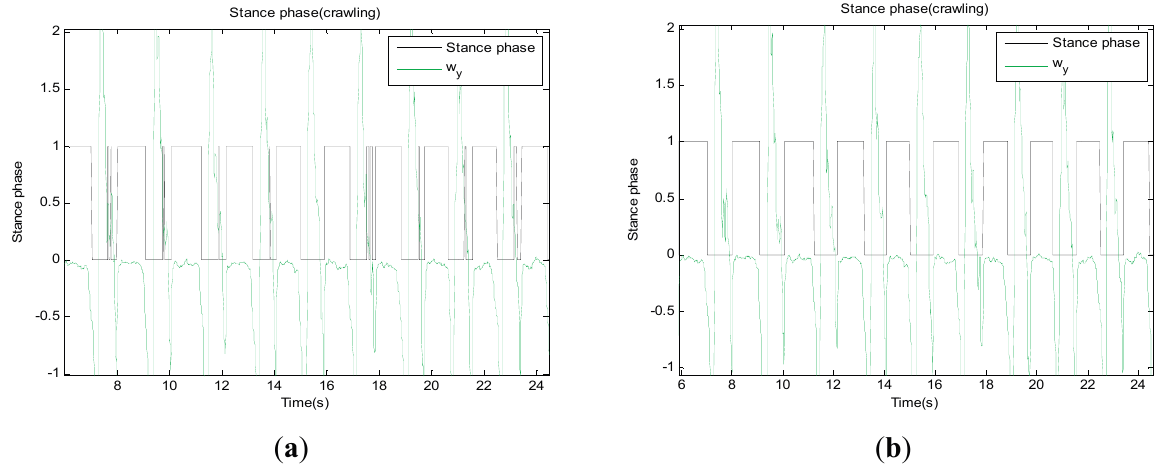
Figure 8. Result of the stance phase detection. Green line shows y-axis gyro and black line shows phase condition. ( a ) shows result of stance phase detection without glitch removal and ( b ) shows without